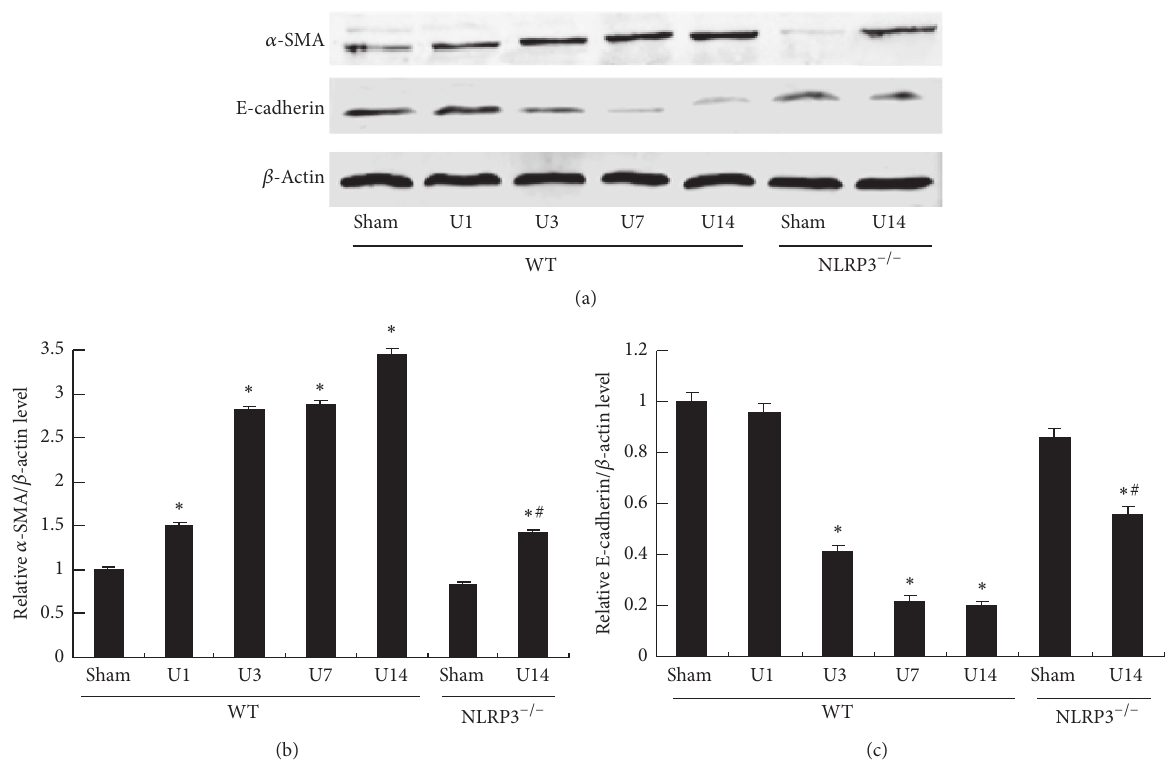
Figure 4: NLRP3 deletion decreases UUO-induced phenotypic alterations in UUO mice. Expression of 𝛼 -SMA and E-cadherin protein detected in kidney samples from different groups (a). Semiquantitative analysis of 𝛼 -SMA expression (b) and E-cadherin expression (c) normalized against 𝛽 -actin. Data represent the mean ± SEM ( 𝑛 = 6 ). ∗ 𝑃 < 0.05 compared with WT/Sham group, # 𝑃 < 0.05 , NLRP3 −/− /U14 group versus WT/U14 group. U1, U3, U7, and U14 indicate that mice were sacrificed on days 1, 3, 7, and 14 after